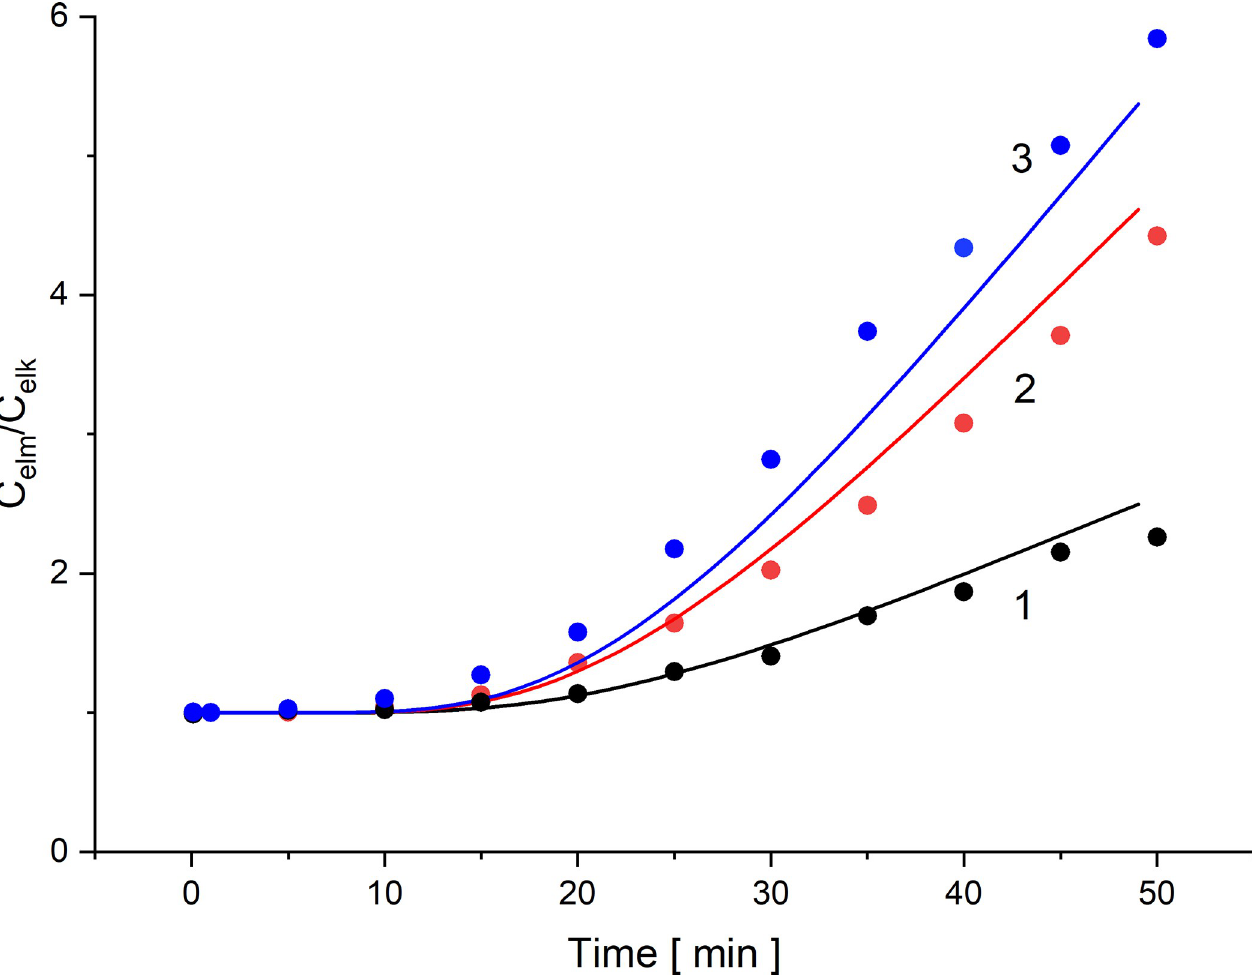
Fig 9. Concentration quotient at the electrode surfaces as a function of time after switching off the mechanical stirring of solutions, for the initial concentration quotients on the membrane ( C h / C l ): 100 ( C h = 1 mol/m 3 ) (1), 500 ( C h = 5 mol/m 3 ) (2) and 1000 ( C h = 10 mol/m 3 ) (3).